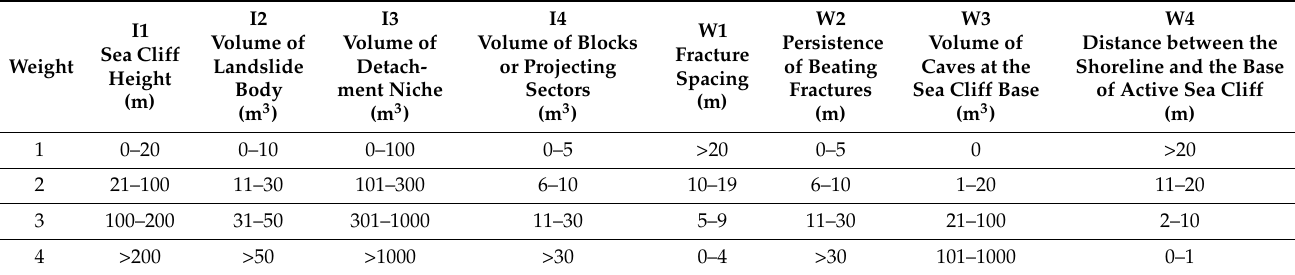
Table 1. Instability (I) and weakness (W) factors adopted to evaluate the geomorphological zonation to landslide along a sea cliff, with relative weight.